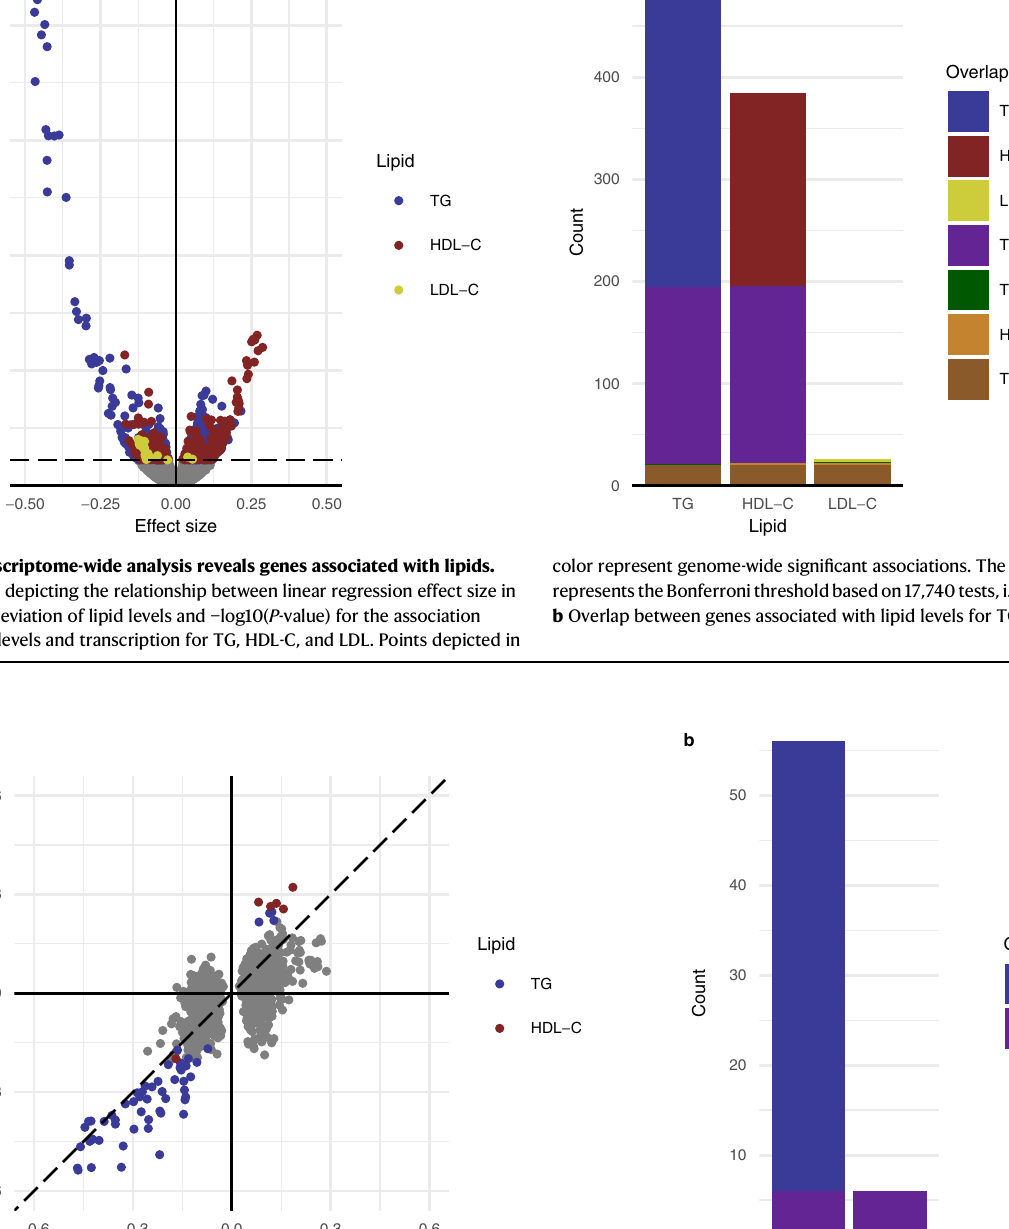
representsFDR-signi fi canteffects. b Overlapbetweengenesaffectedbylipidlevels for TG, HDL-C, and